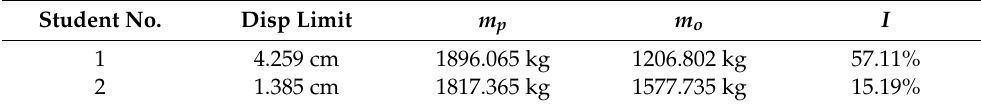
Table 12. Index I of the results for both